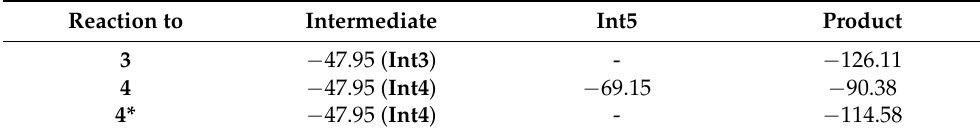
Table 2. Relative energies of intermediates and products (kcal·mol − 1 ) of complexes 3 , 4 and 4* . Reaction to